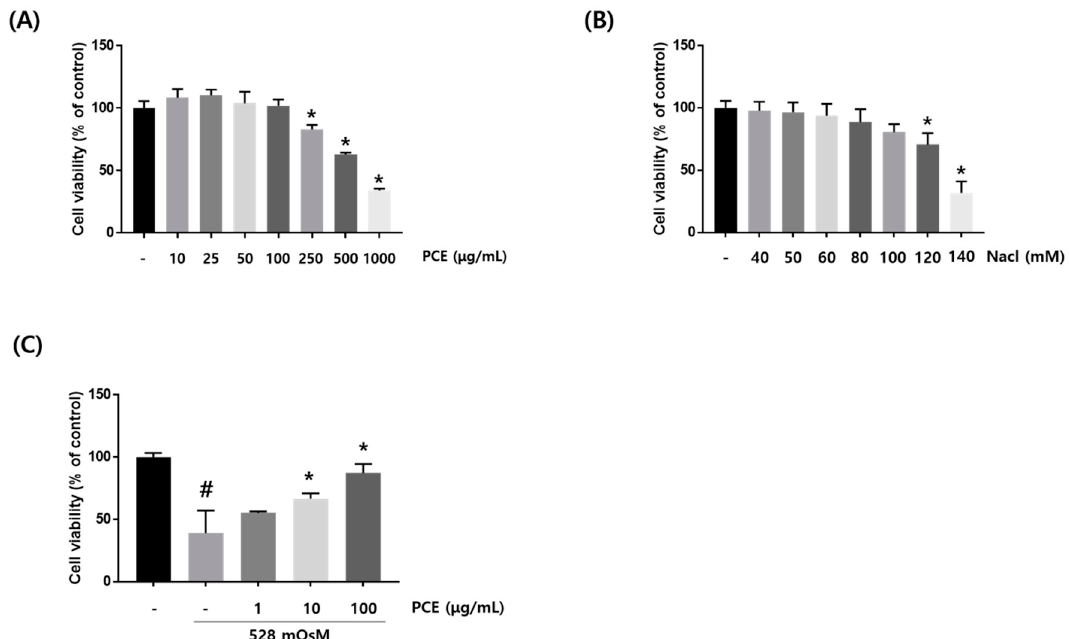
Figure 5. Effects of P. cuspidatum (PCE) on hyperosmolar stress-induced cell death in human corneal epithelial cells (HCECs). ( A , B ) HCECs were treated with PCE or NaCl at different concentrations for 24 h. ( C ) HCECs were co-treated with PCE and hyperosmotic media for 24 h. To investigate cell viability, CCK-8 (Cell Counting Kit-8) assay was performed. Data are the mean ± SEM of three independent experiments for all groups. # p < 0.05, significantly different from untreated group, * p < 0.05, significantly different from hyperosmotic-treated group.